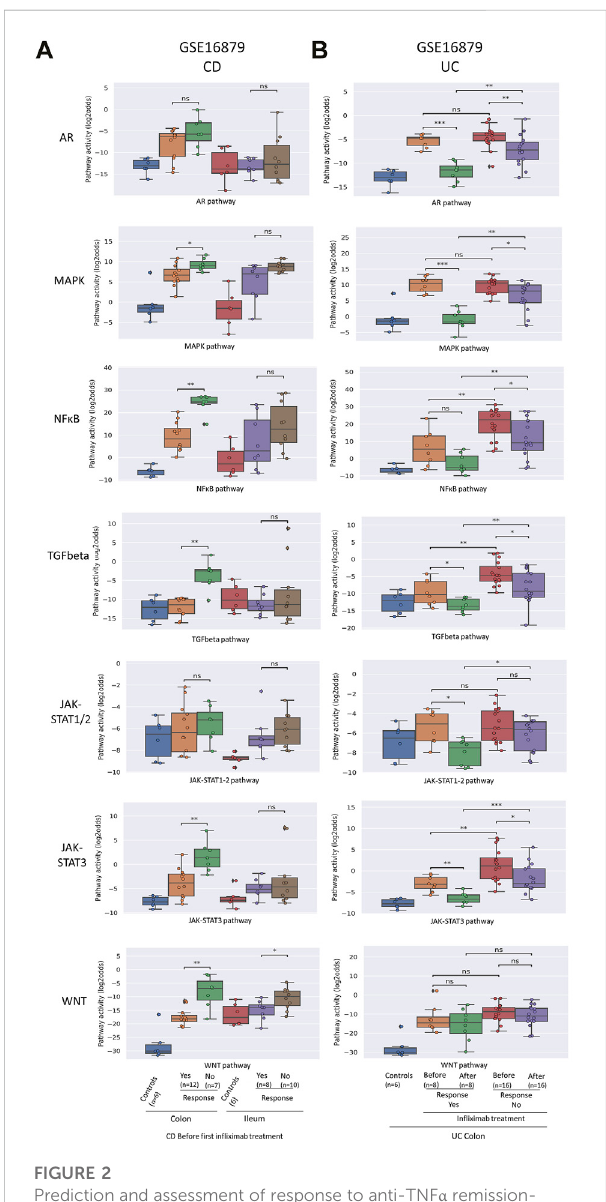
FIGURE 2 Prediction and assessment of response to anti-TNF α remission- induction treatment in CD (A) and UC (B) . Datasets GSE16879. STP activity analysis of intestinal mucosa samples for prediction of response to anti-TNF α remission induction treatment in patients with CD and UC. STP PAS before and after remission induction treatment. For details, see Methods. STP PAS are shown for the AR, MAPK, NF κ B, TGF β , JAK-STAT1/2, JAK-STAT3, and Wnt STPs. Two sided Mann – Whitney – Wilcoxon statistical tests were performed; p-values are indicated in the fi gures as * p < 0.05, ** p < 0.01, *** p < 0.001, **** p < 0.0001, ns: not signi fi cant. For supporting analysis results, see Supplementary Table